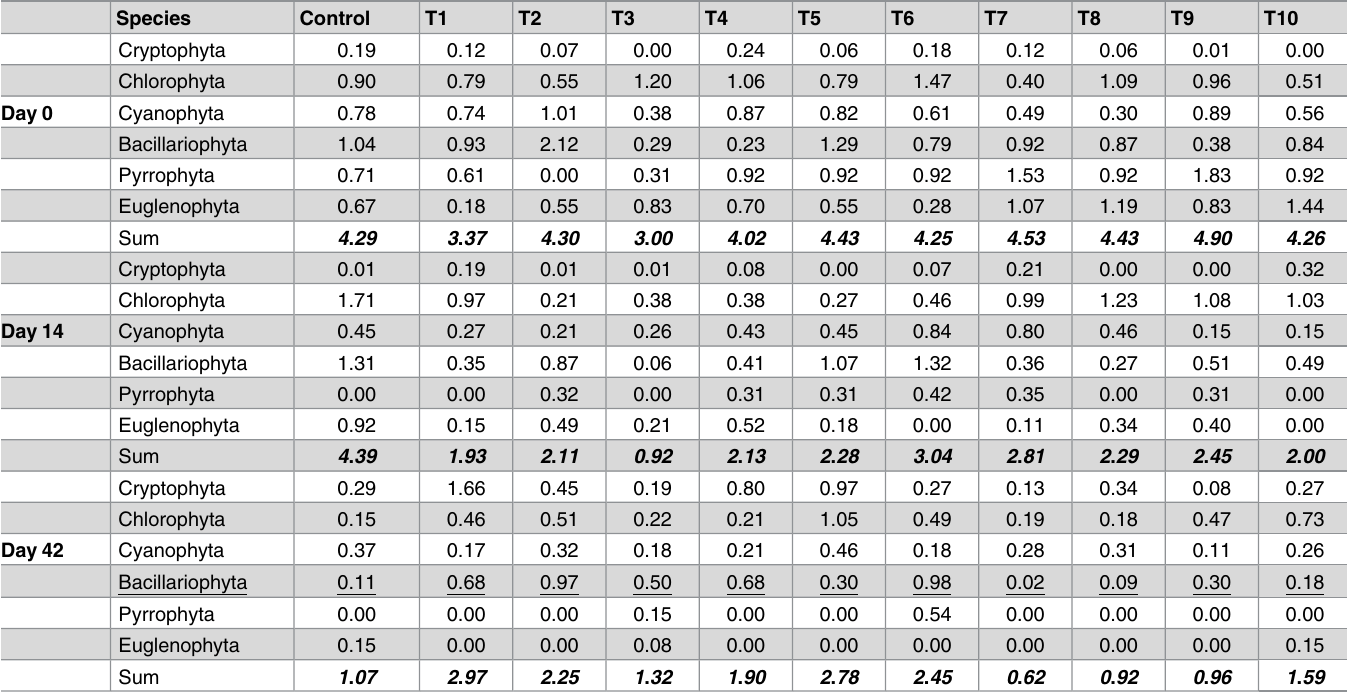
Table 4. Phytoplankton composition and biomass (mg/L) for each treatment at day 0, 14 and 42.